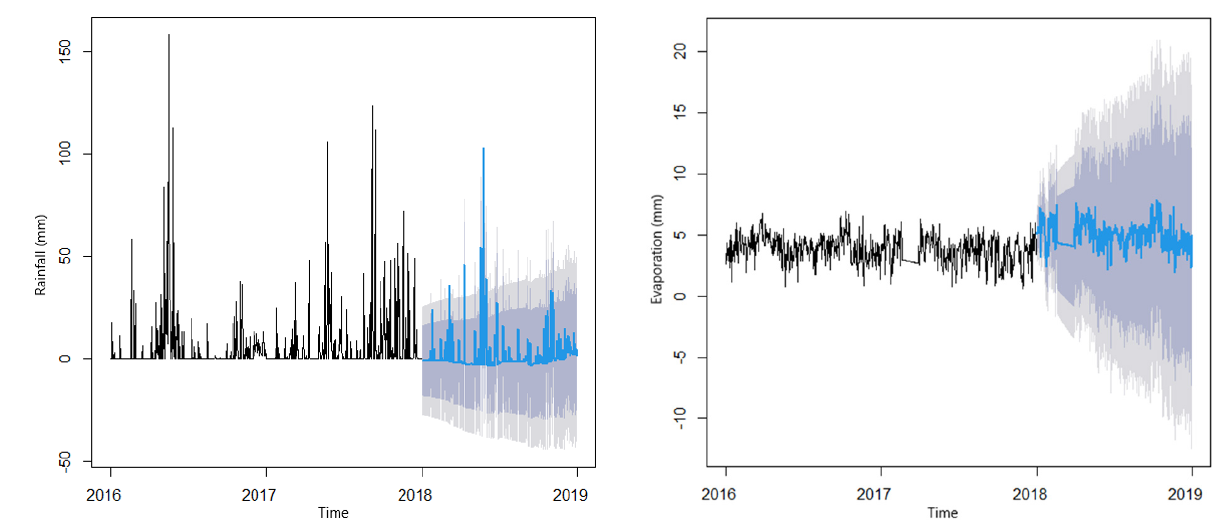
Figure 5: Forecasted rainfall (mm) for 2018. Figure 6: Forecasted evaporation (mm) for 2018.